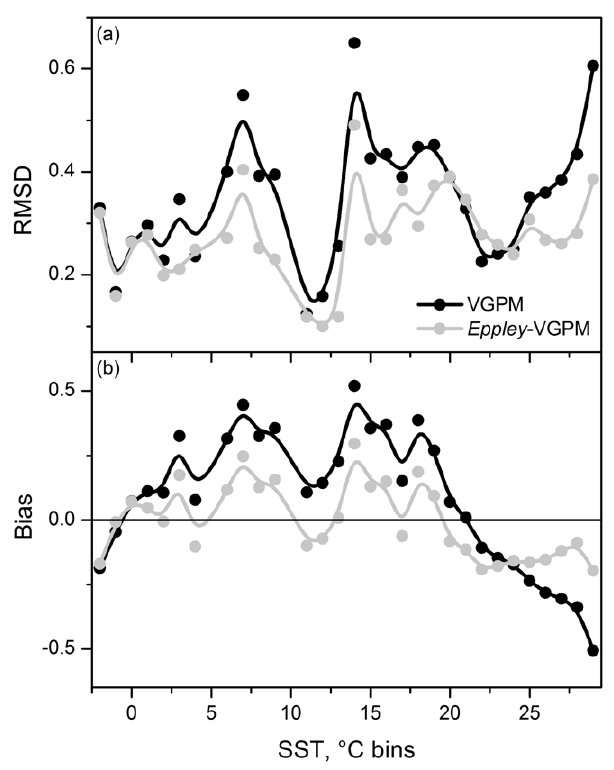
Figure 1. RMSD error and bias for two primary production algorithms. (a) RMSD for VGPM and Eppley -VGPM estimates of NPP based on the observational database of NPP from the fourth PPAR comparison binned by SST. (b) Bias associated with VGPM and Eppley - VGPM estimates of NPP binned by SST.